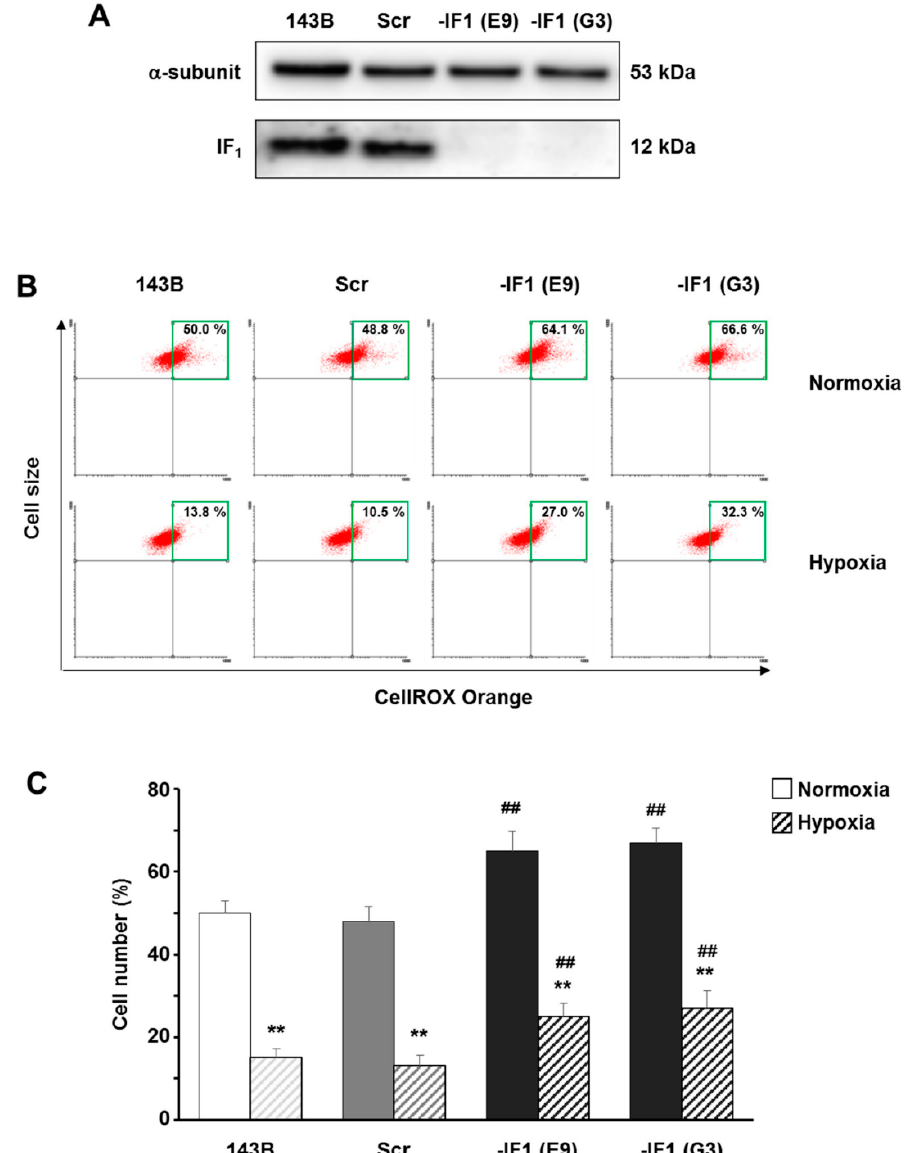
Figure 4. IF 1 affects ROS level in osteosarcoma cells grown under either normoxia or hypoxia. ( A ) Immunoblot analysis of IF 1 protein level in parental cells , scrambled and IF 1 -silenced clones (E9 and G3). ( B ) Representative top right quadrant analysis and ( C ) bars graph of ROS levels measured in all types of CellROX-loaded cells cultured in either normoxia or hypoxia (0.5% O 2 ) for 24 h. Data are means ± SD of four independent experiments. ** p ≤ 0.01 and ## p ≤ 0.01 indicate the statistical significance of data compared to normoxia and to controls, respectively.